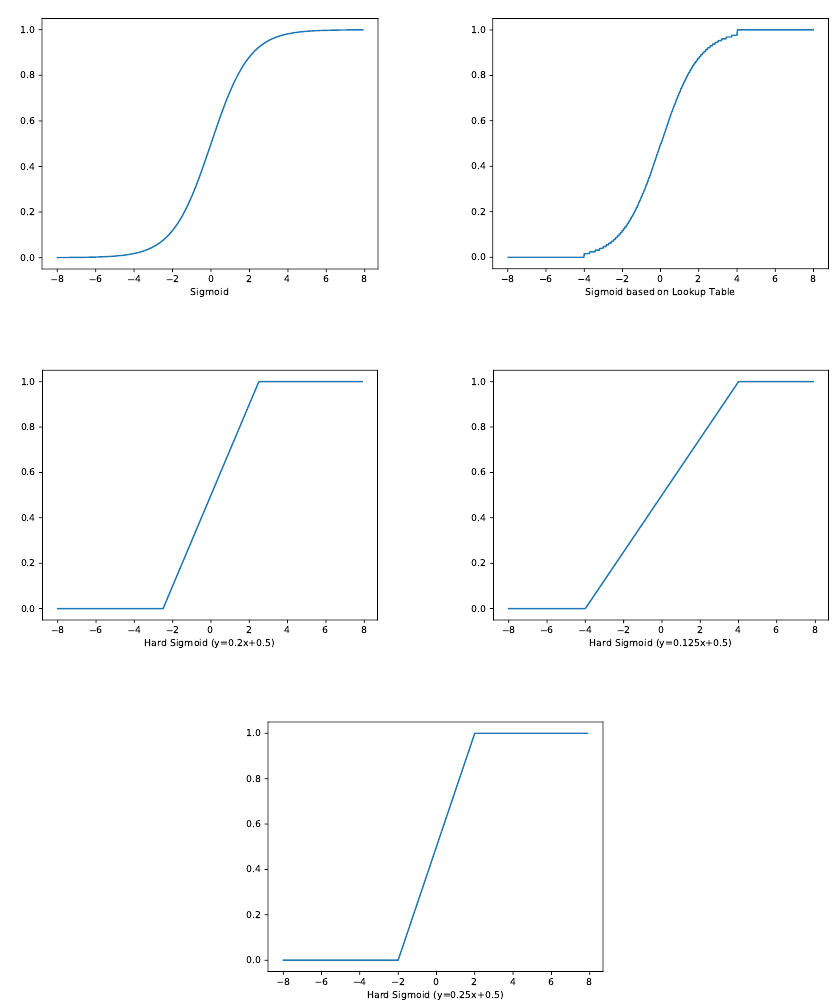
Figure 4. Sigmoid functions and hardware-friendly